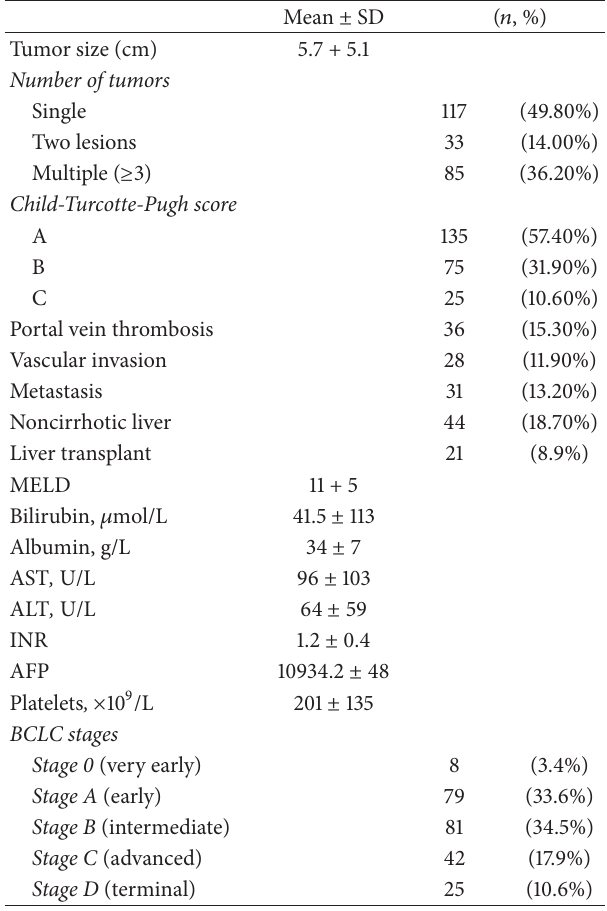
Table 2: Clinical characteristics of hepatocellular carcinoma (HCC)